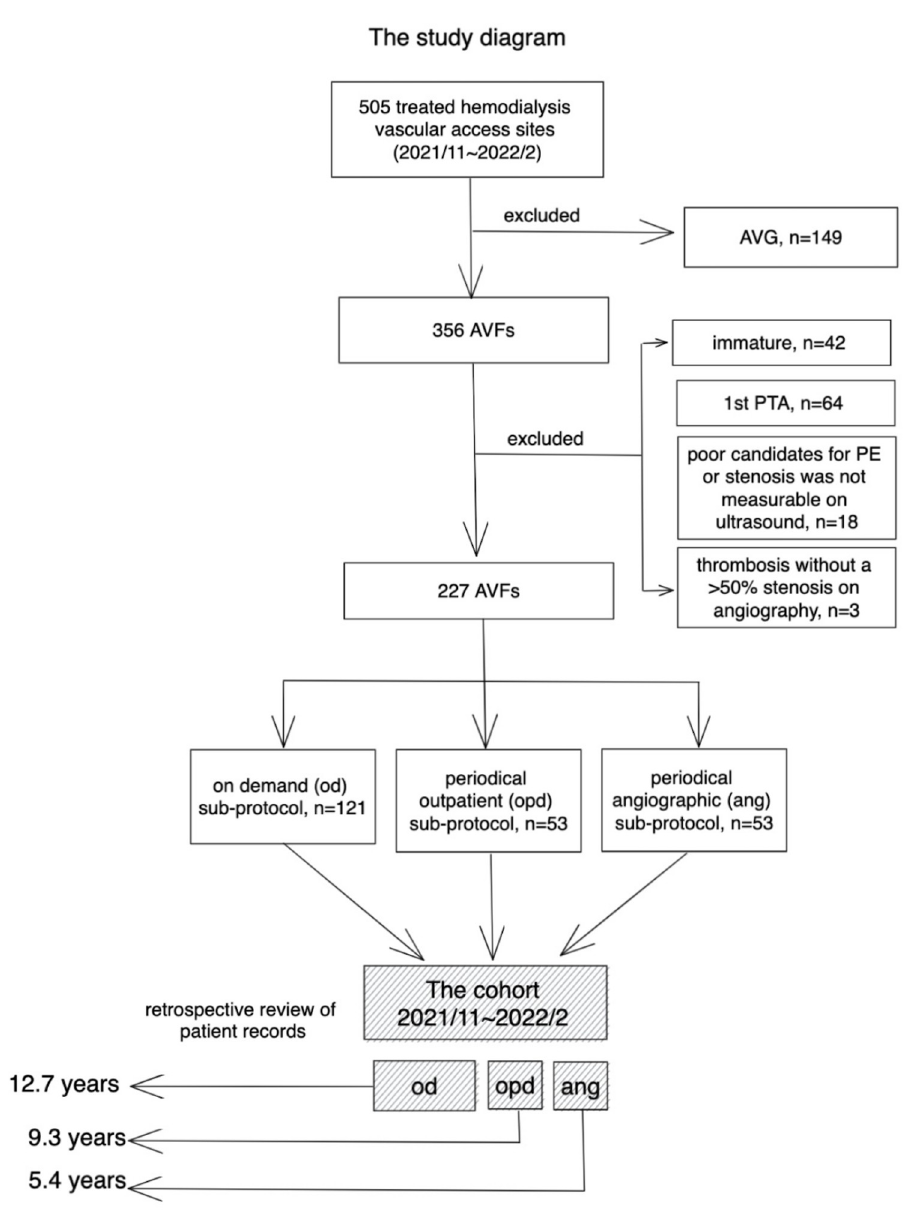
Fig 3. The study flow